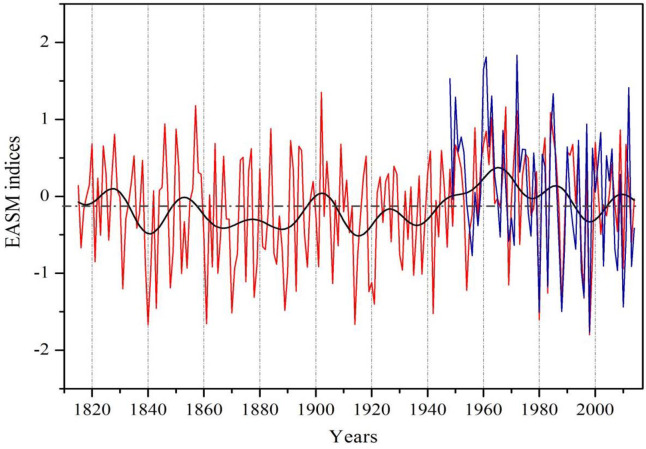
The EASM reconstruction (red line) back to 1815, with the interdecadal variations (bold black line) isolated by using a 20-year fast-Fourier transform filter and the target time series (blue line) for the 1948–2014 period of overlap. The horizontal dashed line represents the mean value of the reconstructed EASM over the period of 1815–2014.